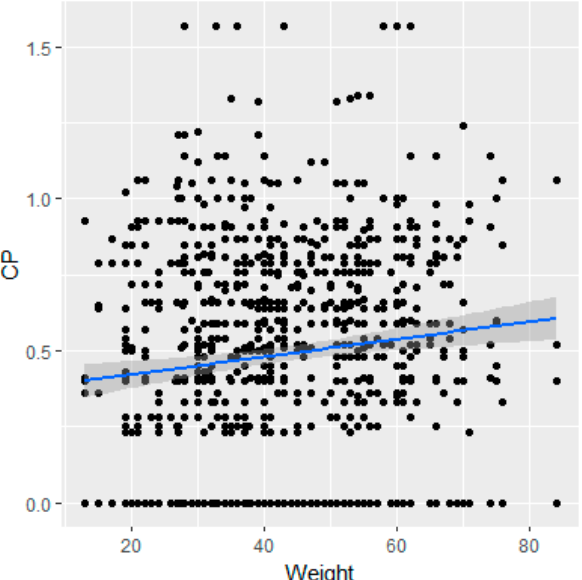
Figure 3. Relationship between the overall percentage occurrence of food items (CP) and weight of speciesPercentage occurrence was moderately positively correlated with weight of rodents as indicated by the blue line.